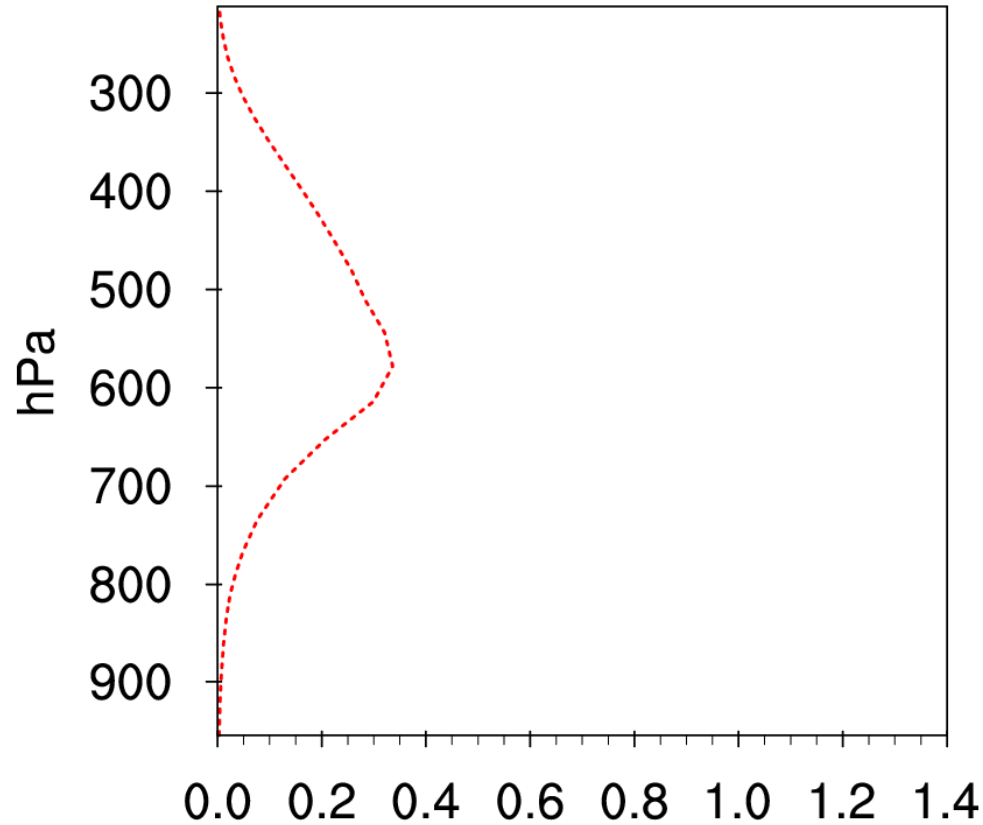
Figure 17. Vertical profile of domain−averaged hail mixing ratio (units: g·kg −1 ) in strong convective areas in Milbrandt MP schemes at 2230 UTC 15 April 2016.